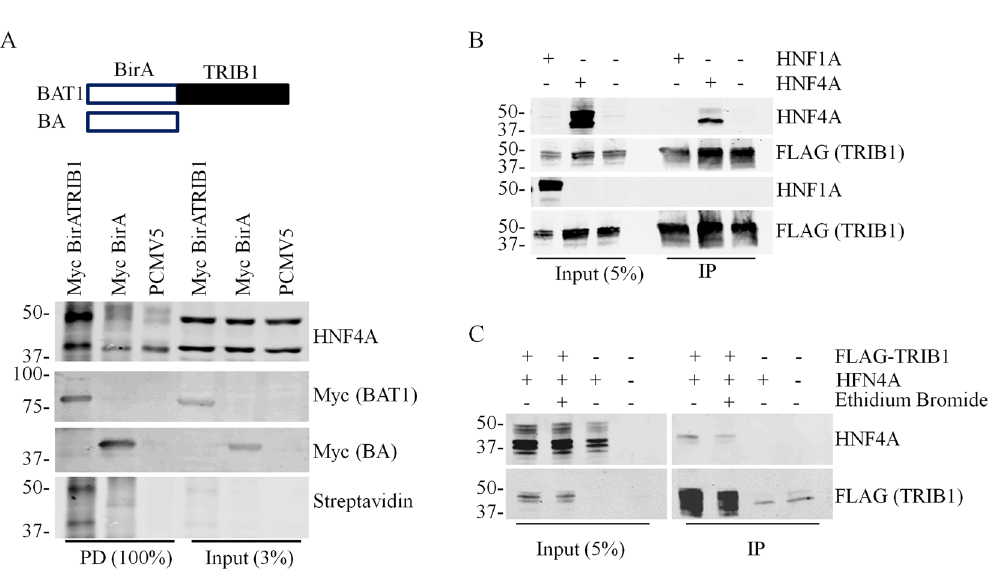
Figure 5. TRIB1 and HNF4A form a complex. ( A ), Constructs coding for myc-tagged BirA alone or inserted N terminal of TRIB1 were co-transfected with HNF4A expression plasmids in HEK293T for 24 h. Following an additional 24 h growth in media supplemented with 0.1 mM biotin, cells were harvested and lysed under denaturing conditions. Biotinylated targets were then isolated using streptavidin beads and analyzed by Western blotting using cognate antibodies followed by streptavidin coupled to IRDye800CW. ( B ), Plasmids encoding either HNF4A or HNF1A were transfected alongside FLAG-tagged TRIB1 plasmids in HEK293T cells. Potential complexes were isolated with FLAG-specific immunobeads and analyzed by Western blotting. ( C ), Interaction is independent of DNA binding. Ethidium bromide (0.2 mg/ml) was included during the immunoprecipitation. Samples were analyzed by Western blotting using the indicated